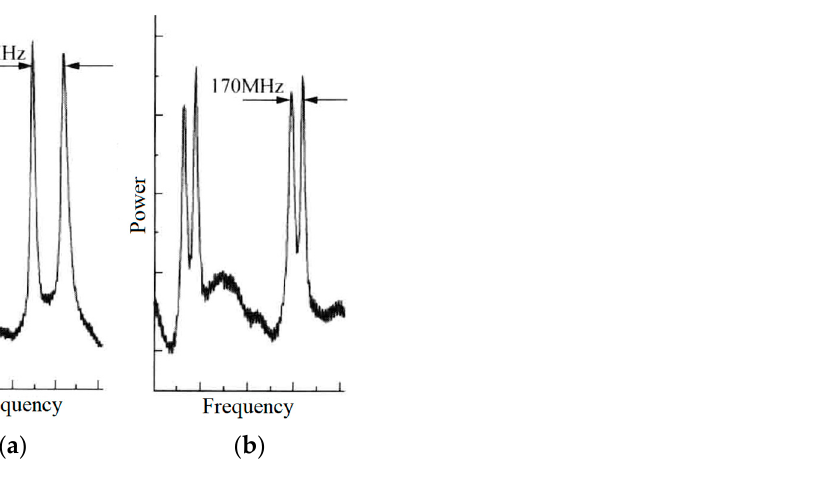
Figure 18. Oscillating spectrum of dual-frequency laser with different frequency difference of ( a ) 525 MHz and ( b ) 170 MHz [28] .